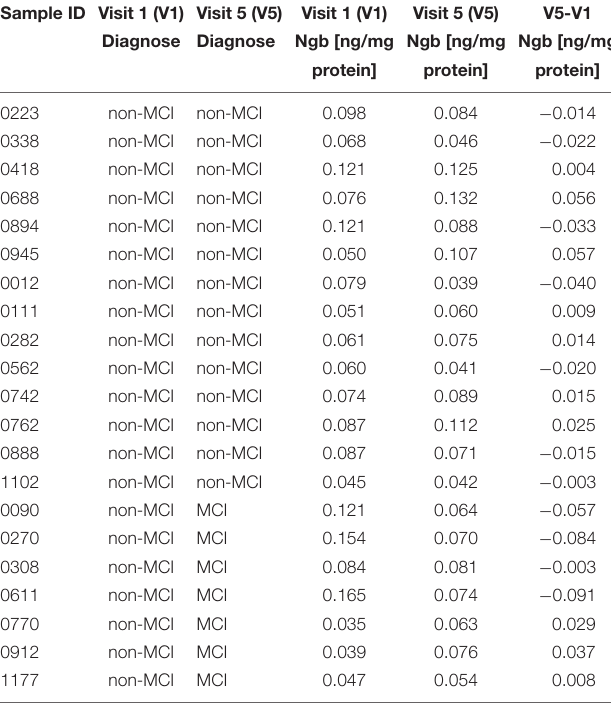
TABLE 2 | Determination of neuroglobin (Ngb) levels in the